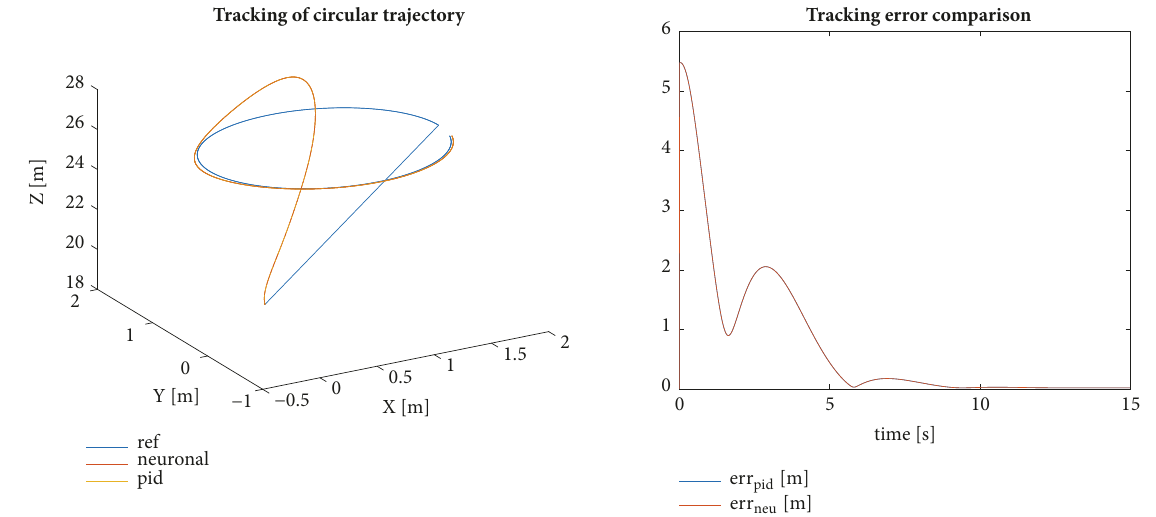
Figure 7: UAV tracking of a circular trajectory (left) and its tracking error (right).